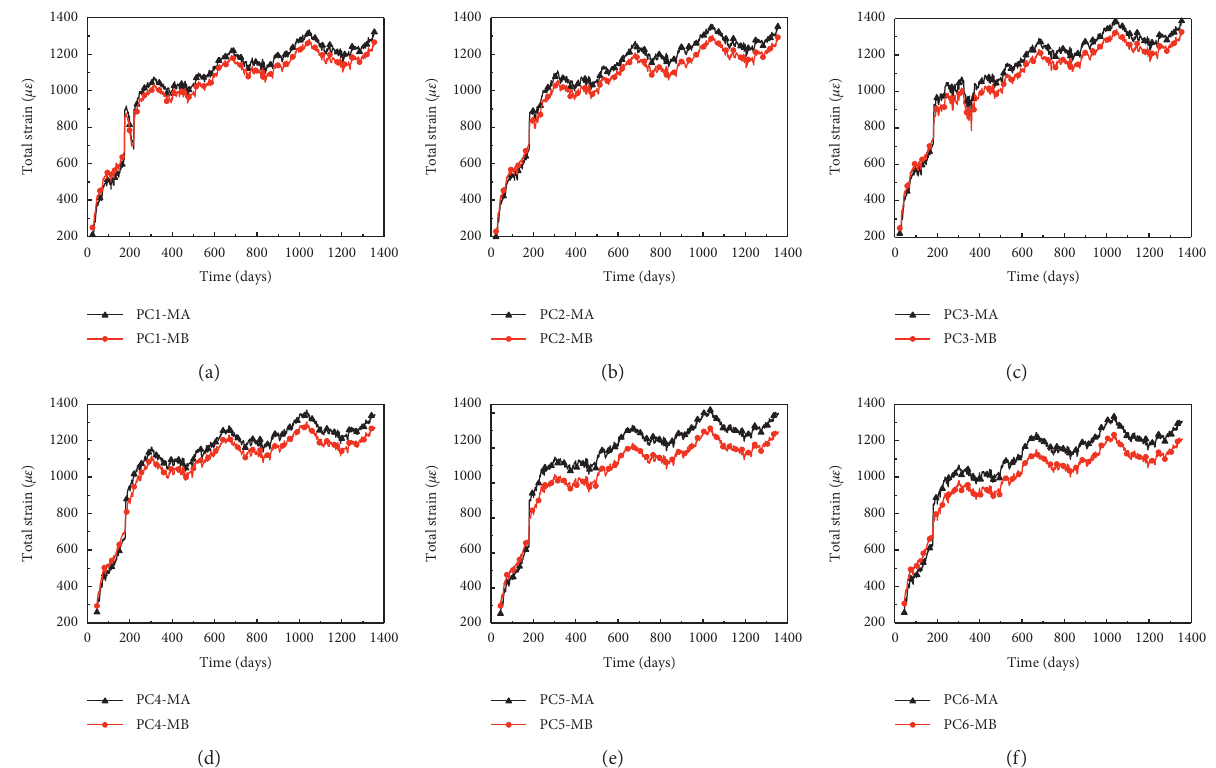
Figure 6: The total strain history of test beams: (a) PC1; (b) PC2; (c) PC3; (d) PC4; (e) PC5; (f)